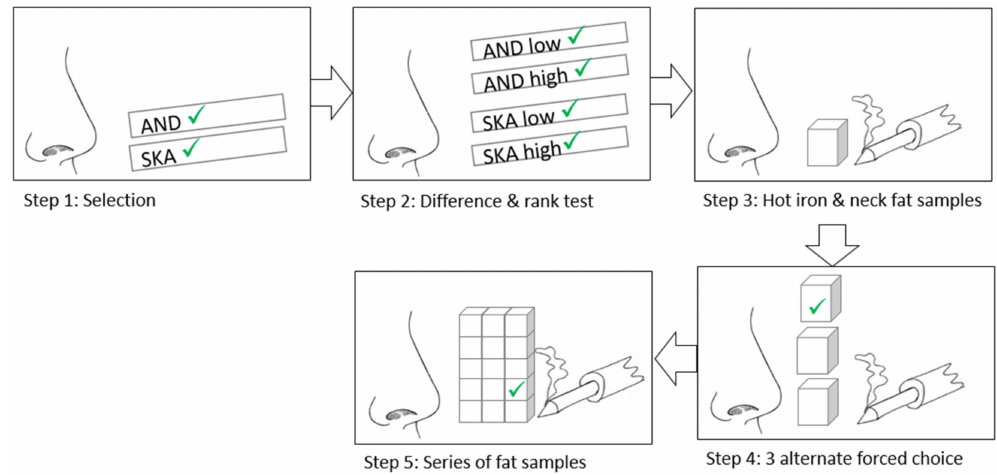
Figure 1. Illustration of the selection and training protocol for panelists of an olfactory panel for boar taint. In the first step there is a selection for SKA and AND sensitivity using smell strips. In the second step panelists are asked to discriminate between AND and SKA and rank smell strips according to concentration. In the third step the hot iron method and scoring system on neck fat samples is taught. In the fourth, 3 alternate forced choice tests are performed where panelists must identify a positive sample among two negative samples. In the fifth step the panelists are asked to smell 3 series of fat samples and identify positive